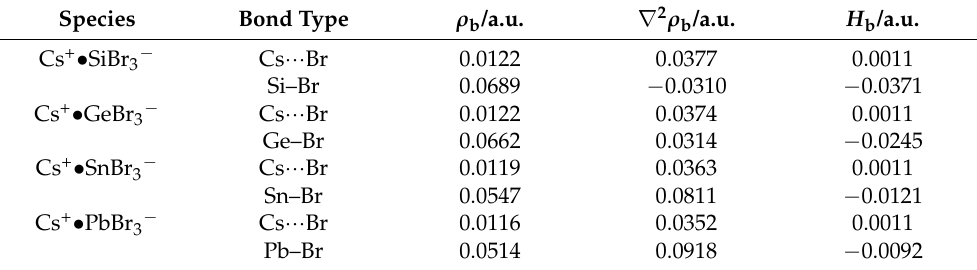
Table 2. Selected QTAIM-based topological charge density properties at Tt–Br and Cs ··· Br bcps of